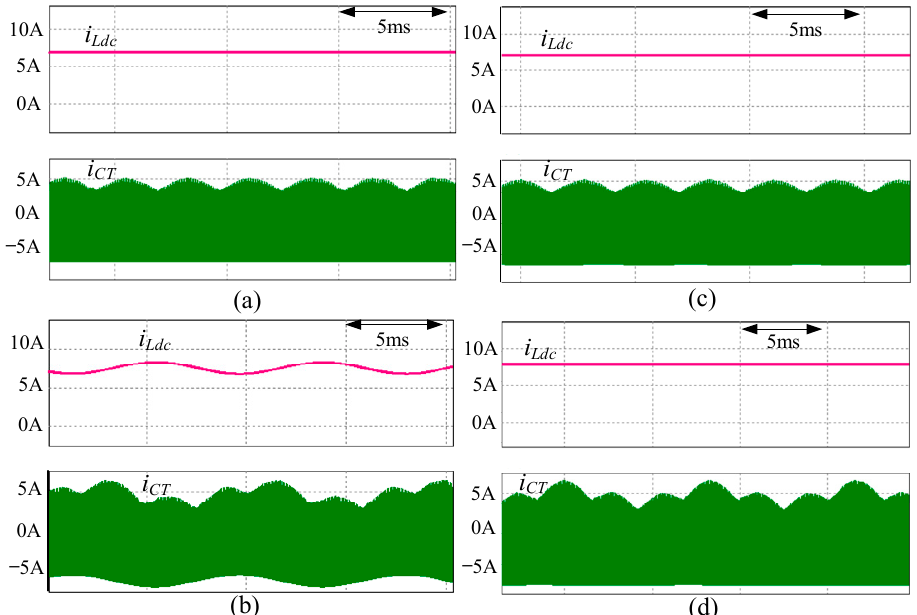
Figure 10. Close-to-120 Hz FFT results of current i CT of the DC-link capacitor under test for ( a , c , e ) balanced and ( b , d , f ) unbalanced load conditions in the ( a , b ) full-scale voltage rating VSI, ( c , d ) con- ventional down-scale voltage rating evaluation system, and ( e , f ) proposed down-scale voltage rat- ing evaluation system.